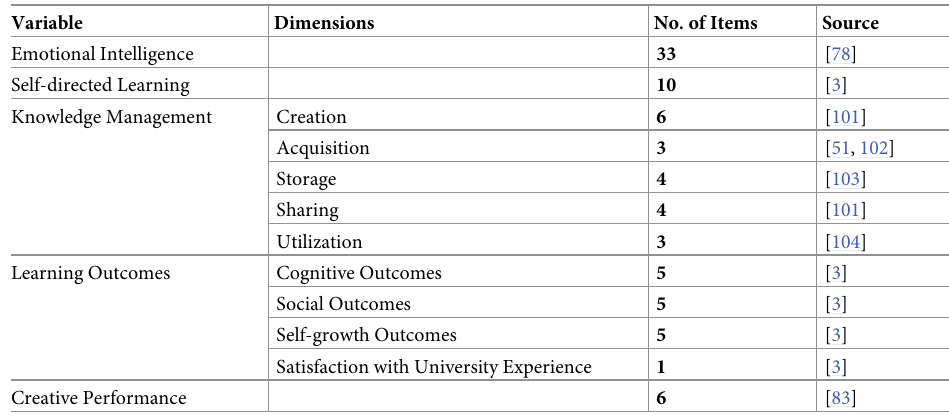
Table 1. Source of measurement instruments.